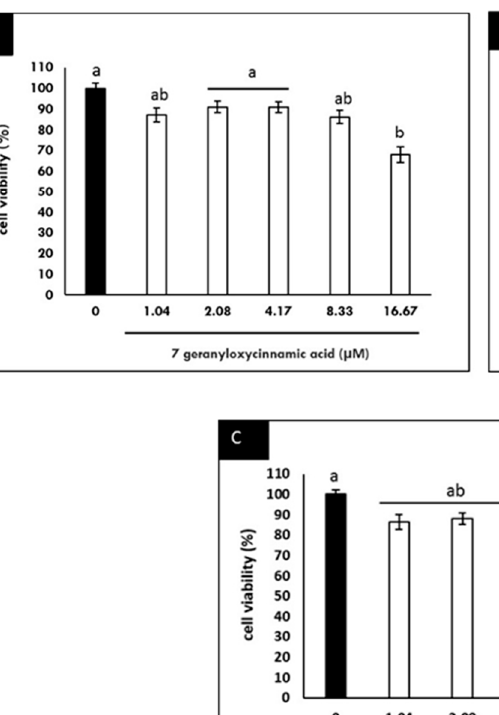
Figure 2. Fluorescence microscopy to confirm the differentiation process of human neuroblastoma (SH-SY5Y) cells. ( a ) Phase contrast of undifferentiated cells maintained in complete growth media. ( b ) Phase contrast of differentiated cells cultured in complete growth media treated with 10 µM of retinoic acid (RA). ( c ) Fluorescence micrograph of undifferentiated cells cultured in complete growth media and stained with 4 ′ ,6-Diamidine-2 ′ -phenylindole dihydrochloride (DAPI). ( d ) Fluorescence micrograph of differentiated cells cultured in complete growth media treated with 10 µM of RA and stained with DAPI, increases in green fluorescent intensity indicated highly expressed tuj-1 in both cytoplasm and neurites. CY = cytoplasm, EN = extended neurites, SN = short neurites. Magnification (× 20). ( e ) Neurite length in undifferentiated (0 µM RA-treated) and differentiated (10 µM RA-treated) SH-SY5Y cells after 7 days of differentiation. Data are displayed as means ± SD of triplicate experiments; means with different letters denote significant difference ( p < 0.05).